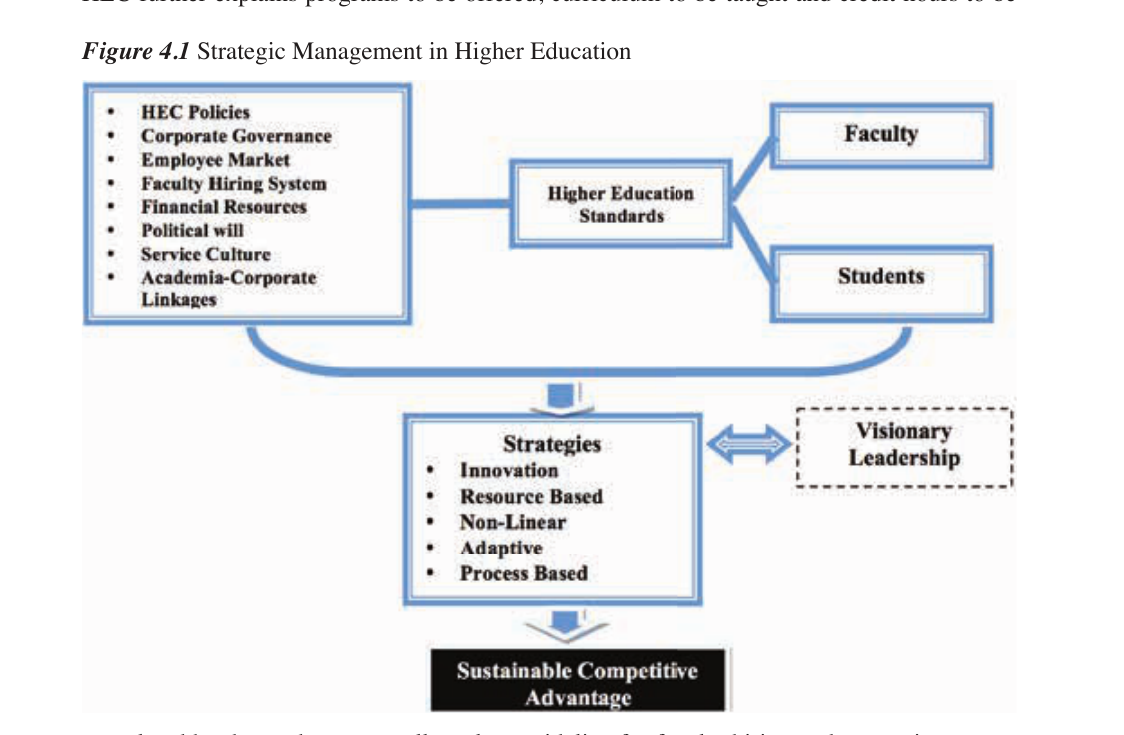
Figure 4.1 Strategic Management in